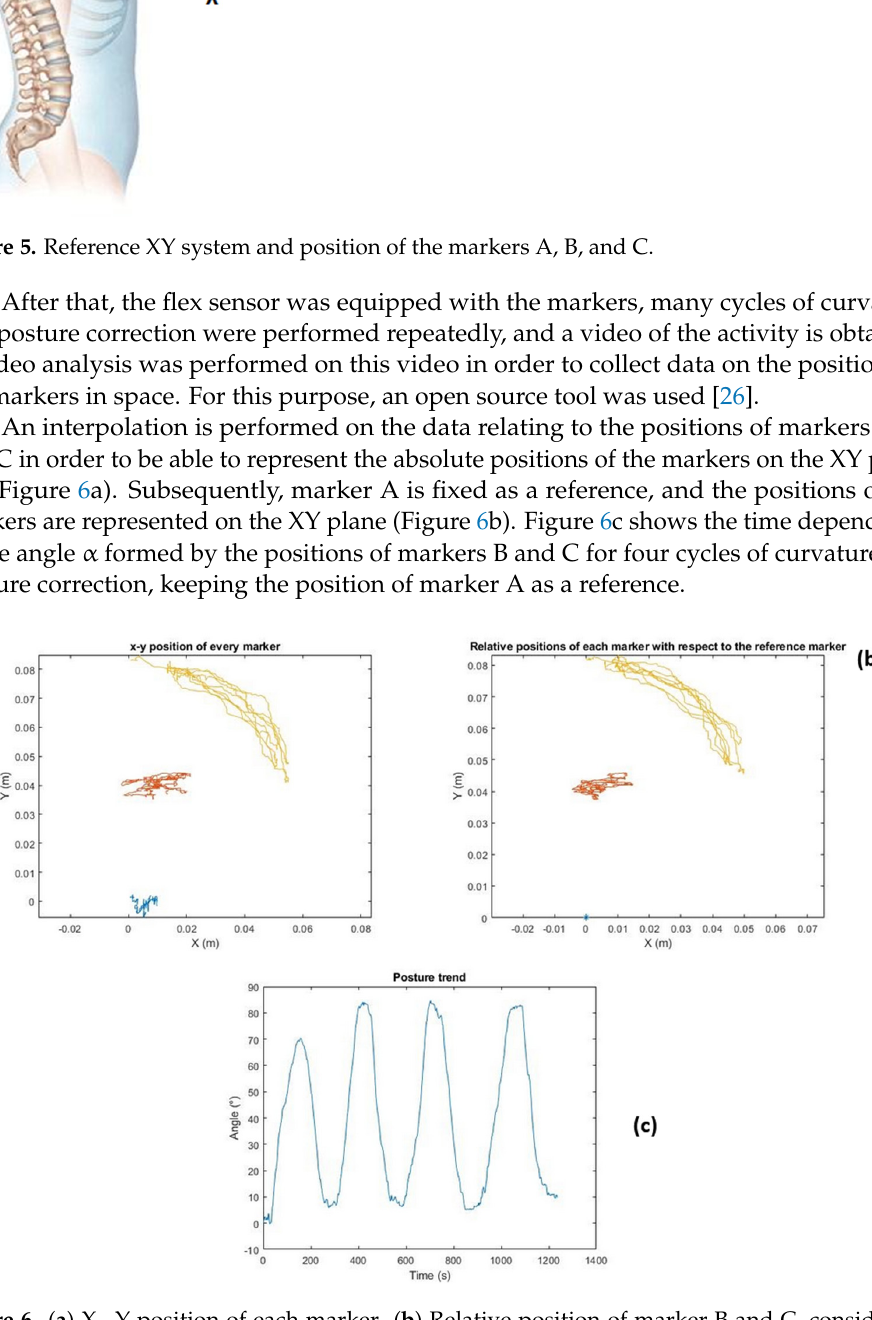
Figure 5. Reference XY system and position of the markers A, B, and C.